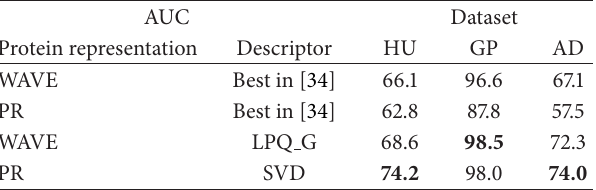
Table 6: Comparisons with previous versions of WAVE and PR. AUC Dataset Protein